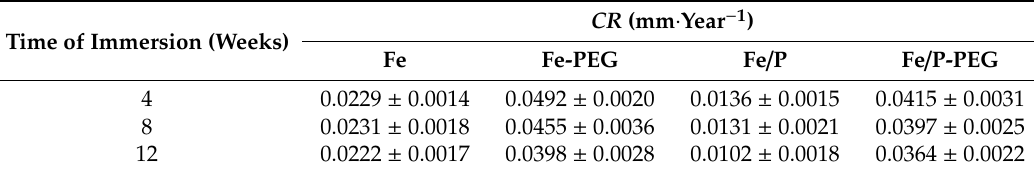
Table 3. The values of corrosion rate ( CR ) of iron-based foams (Fe, Fe-PEG, Fe / P, and Fe / P-PEG) immersed in Hanks’ solution during 4, 8, and 12 weeks.